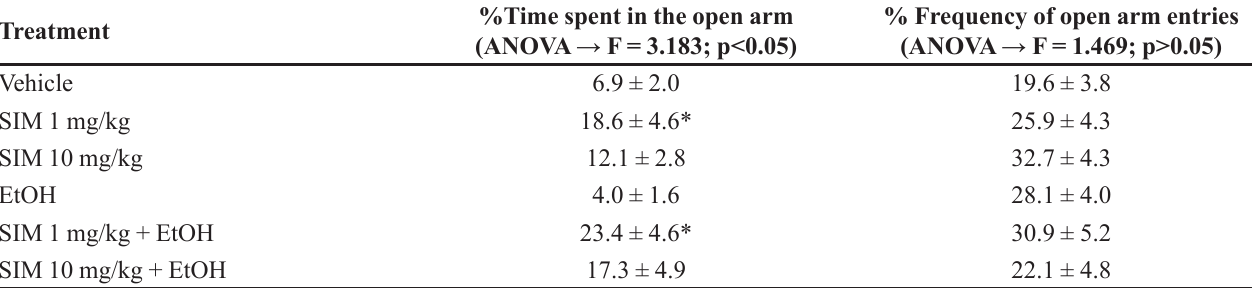
TABLE IV - Behavioral responses in the elevated plus-maze following sub-chronic simvastatin (SIM) treatment in rats with ethanol (EtOH) withdrawal syndrome - percentage of time spent in the open arm and percentage of frequency of open arm entries. Values are expressed as the mean ± standard error of the mean; n = 10, *p<0.05. Statistically significant compared to the vehicle group (analysis of variance [ANOVA] followed by the Newman-Keuls test) %Time spent in the open arm Treatment (ANOVA → F = 3.183; p<0.05) (ANOVA → F = 1.469;